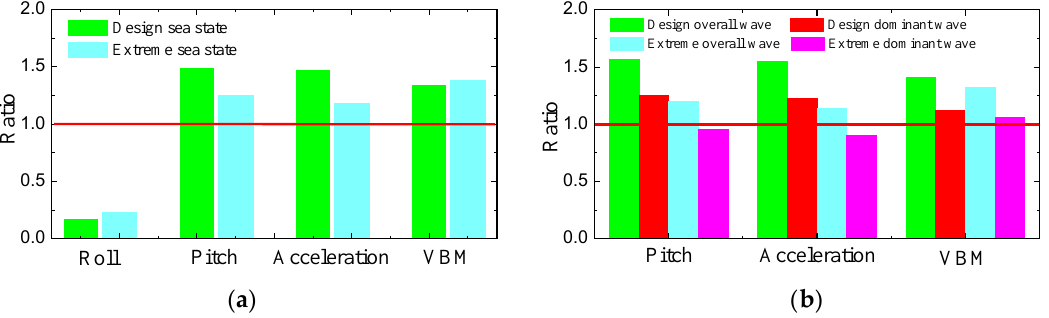
Figure 29. Comparison of ship response results: ( a ) ratio of small/large model results; and ( b ) ratio of small/large model responses under unit wave height.